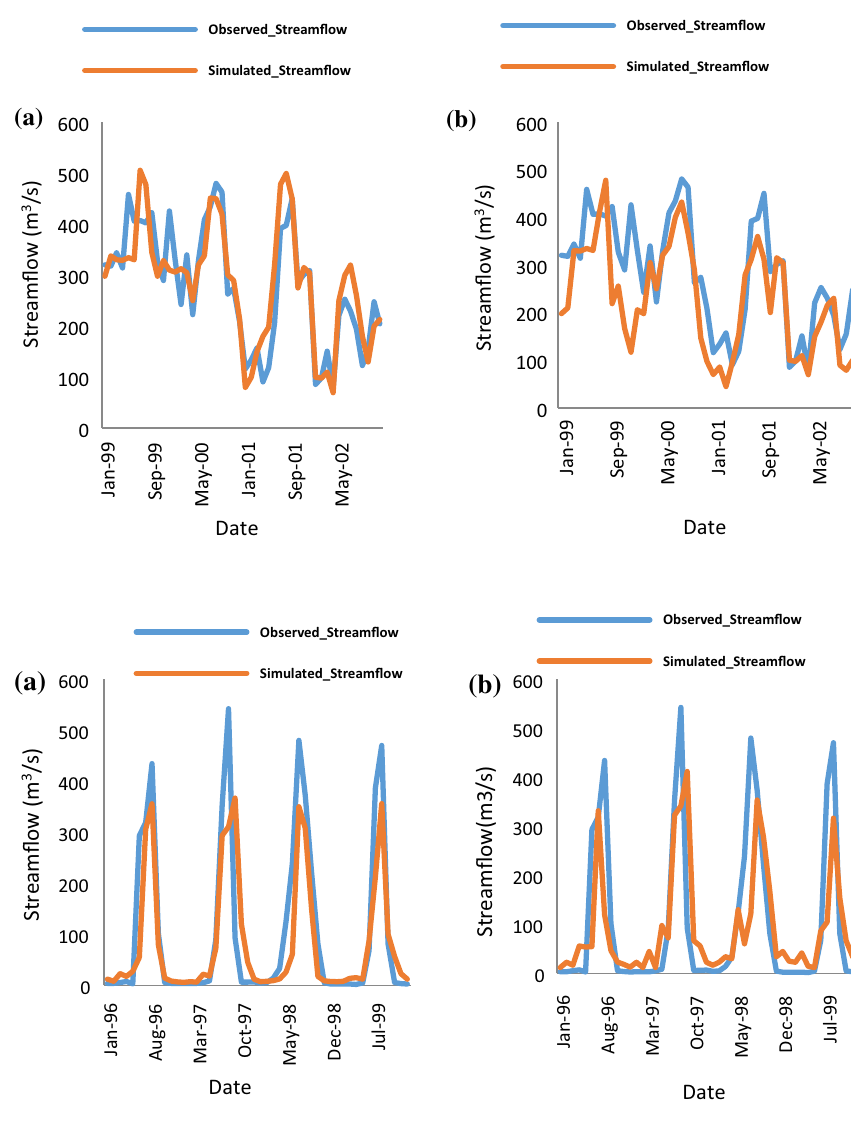
Fig. 13 Hydrograph of the observed and calibrated monthly flow for the calibra- tion period of Pandoh dam for a ERA-Interim and b IMD weather